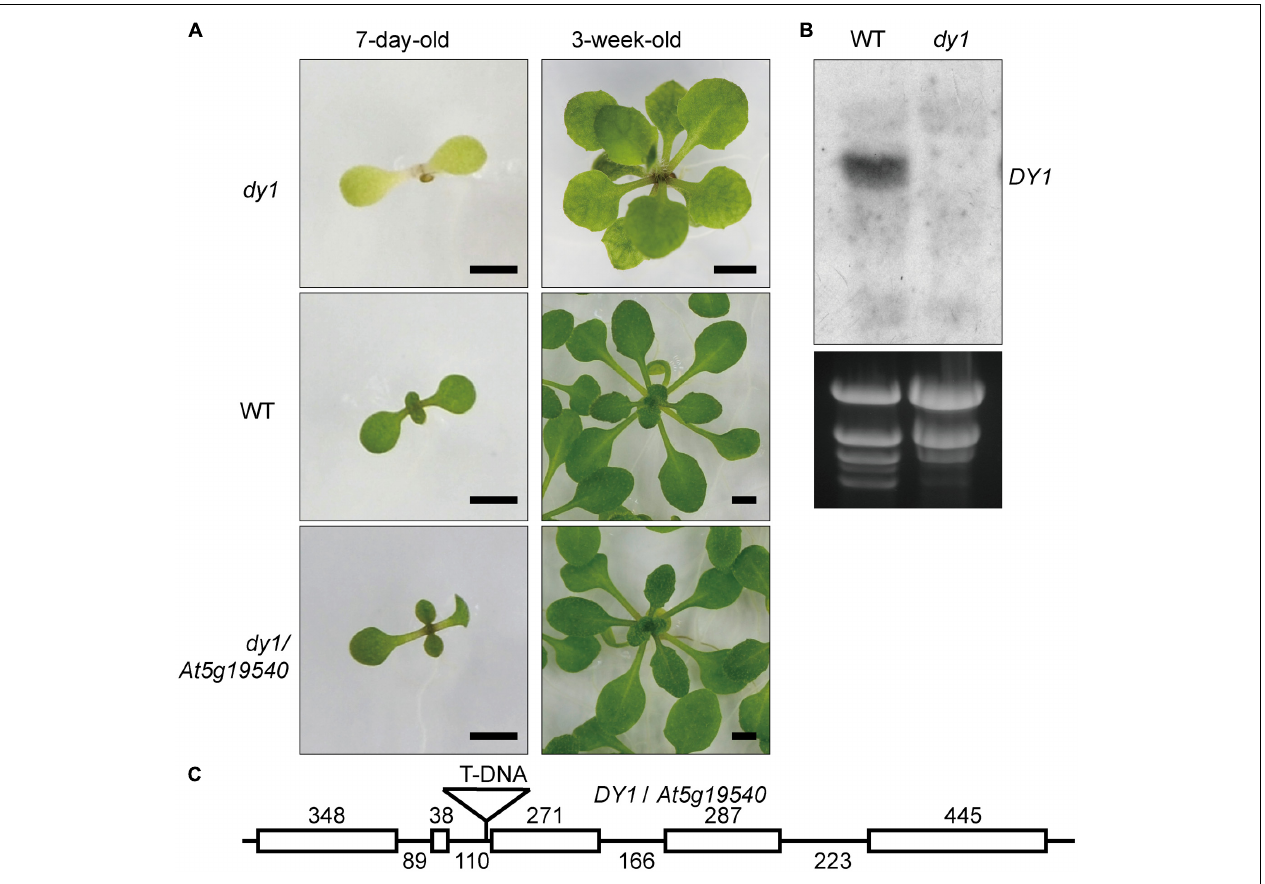
FIGURE 1 | Phenotype and characterization of the dy1 mutant plant. (A) dy1 , WT and At5g19540 transformed dy1 plants grown on MS plates. Bars = 2 mm. (B) Northern blot showing the silence of At5g19540 in the dy1 mutant. (C) T-DNA insertion position of dy1 . The insertion is 3 bp upstream the third exon of At5g19540 . Sizes of each intron and exon are